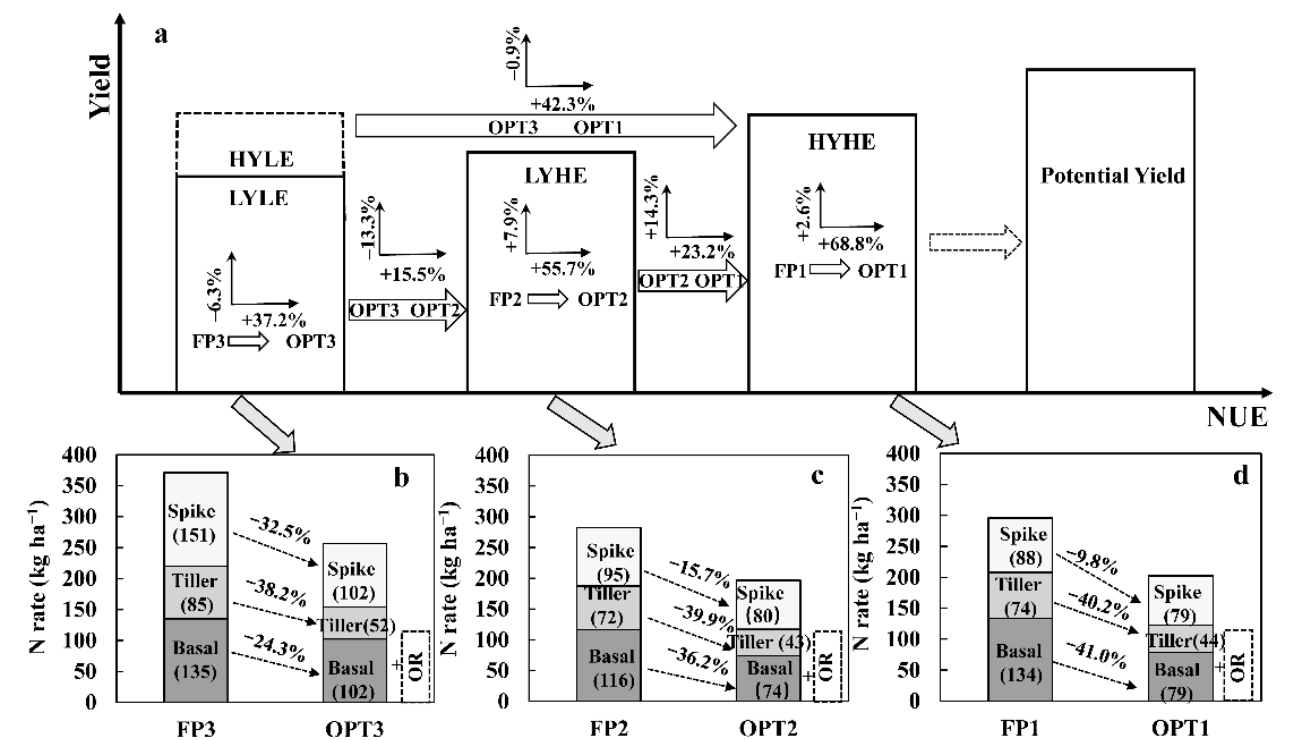
Figure 3. Schematic diagram of the response of rice yield and nitrogen use e ffi ciency (NUE) to optimized N management for four categories of farmers. ( a ) Axes within boxes represent the change in NUE (x-axis) and yield (y-axis) when farmers of each type transition from current practices (FP) to optimized management (OPT). Axes above arrows between boxes represent the change in NUE and yield when farmers transition within OPTs. ( b – d ) show N application rates at basal, tiller and spike growth stages for current and optimized practices. Numbers above dotted arrows represent the percentage decrease in N application rate under OPT management at di ff erent fertilizer stages, compared with FP. The dashed box ‘OR’ represents the addition of organic fertilizers. Data derived from studies published electronically from 2000 to